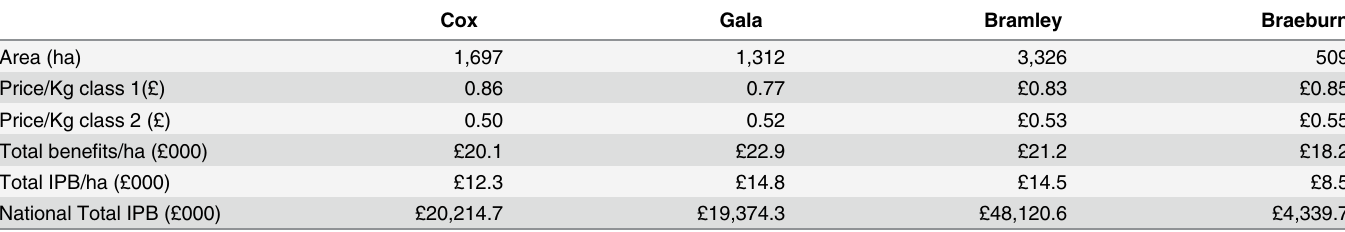
Table 1. Summary of the economic benefits of pollination services to UK Apple varieties in 2012. Cox Gala Bramley